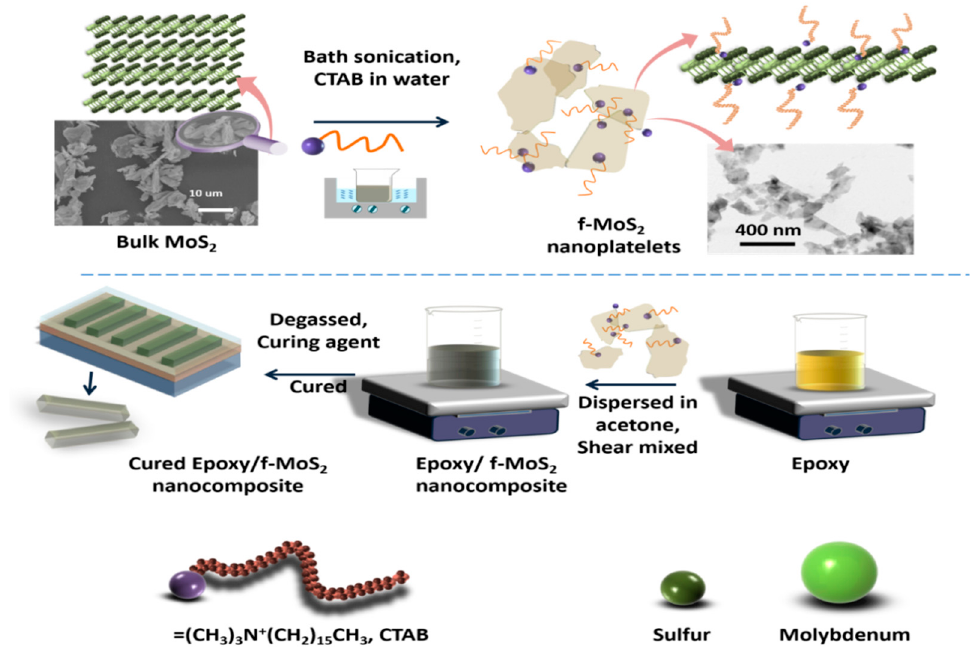
Figure 1. The route to obtaining f- MoS 2 nanoplatelets and dispersion of f-MoS 2 nanoplatelets in the epoxy matrix.